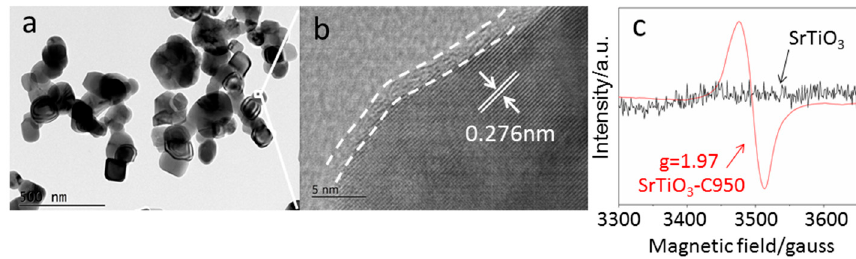
Figure 2. Transmission Electron Microscope (TEM) image ( a ), High Resolution Transmission Electron Microscope (HRTEM) image ( b ) and Electron Paramagnetic Resonance (EPR) image ( c ) of SrTiO 3 -